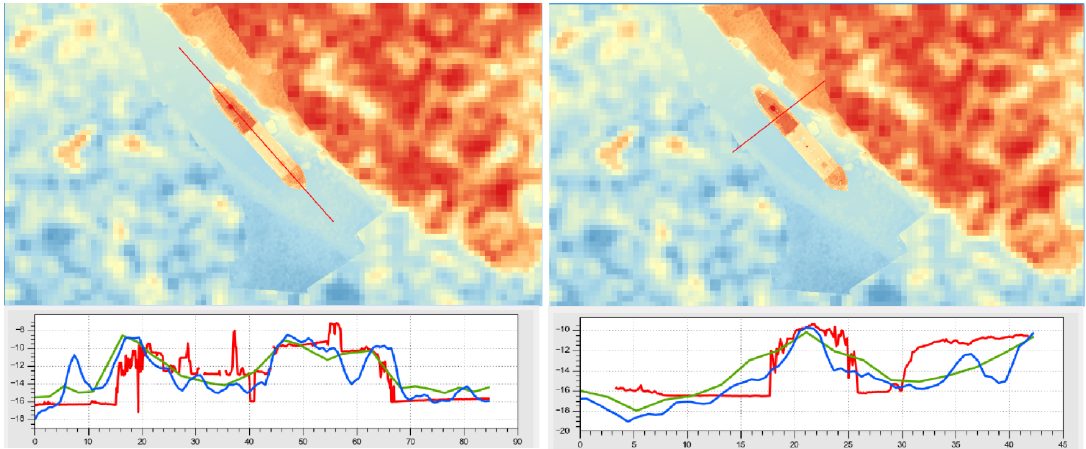
Figure 16: Overview of Elphis I bathymetry maps: (a) sonar-derived bathymetry; (b) original resolution (2 m) satellite-derived bathymetry (c) higher resolution (0.5 m) pan-sharpened satellite-derived bathymetry.